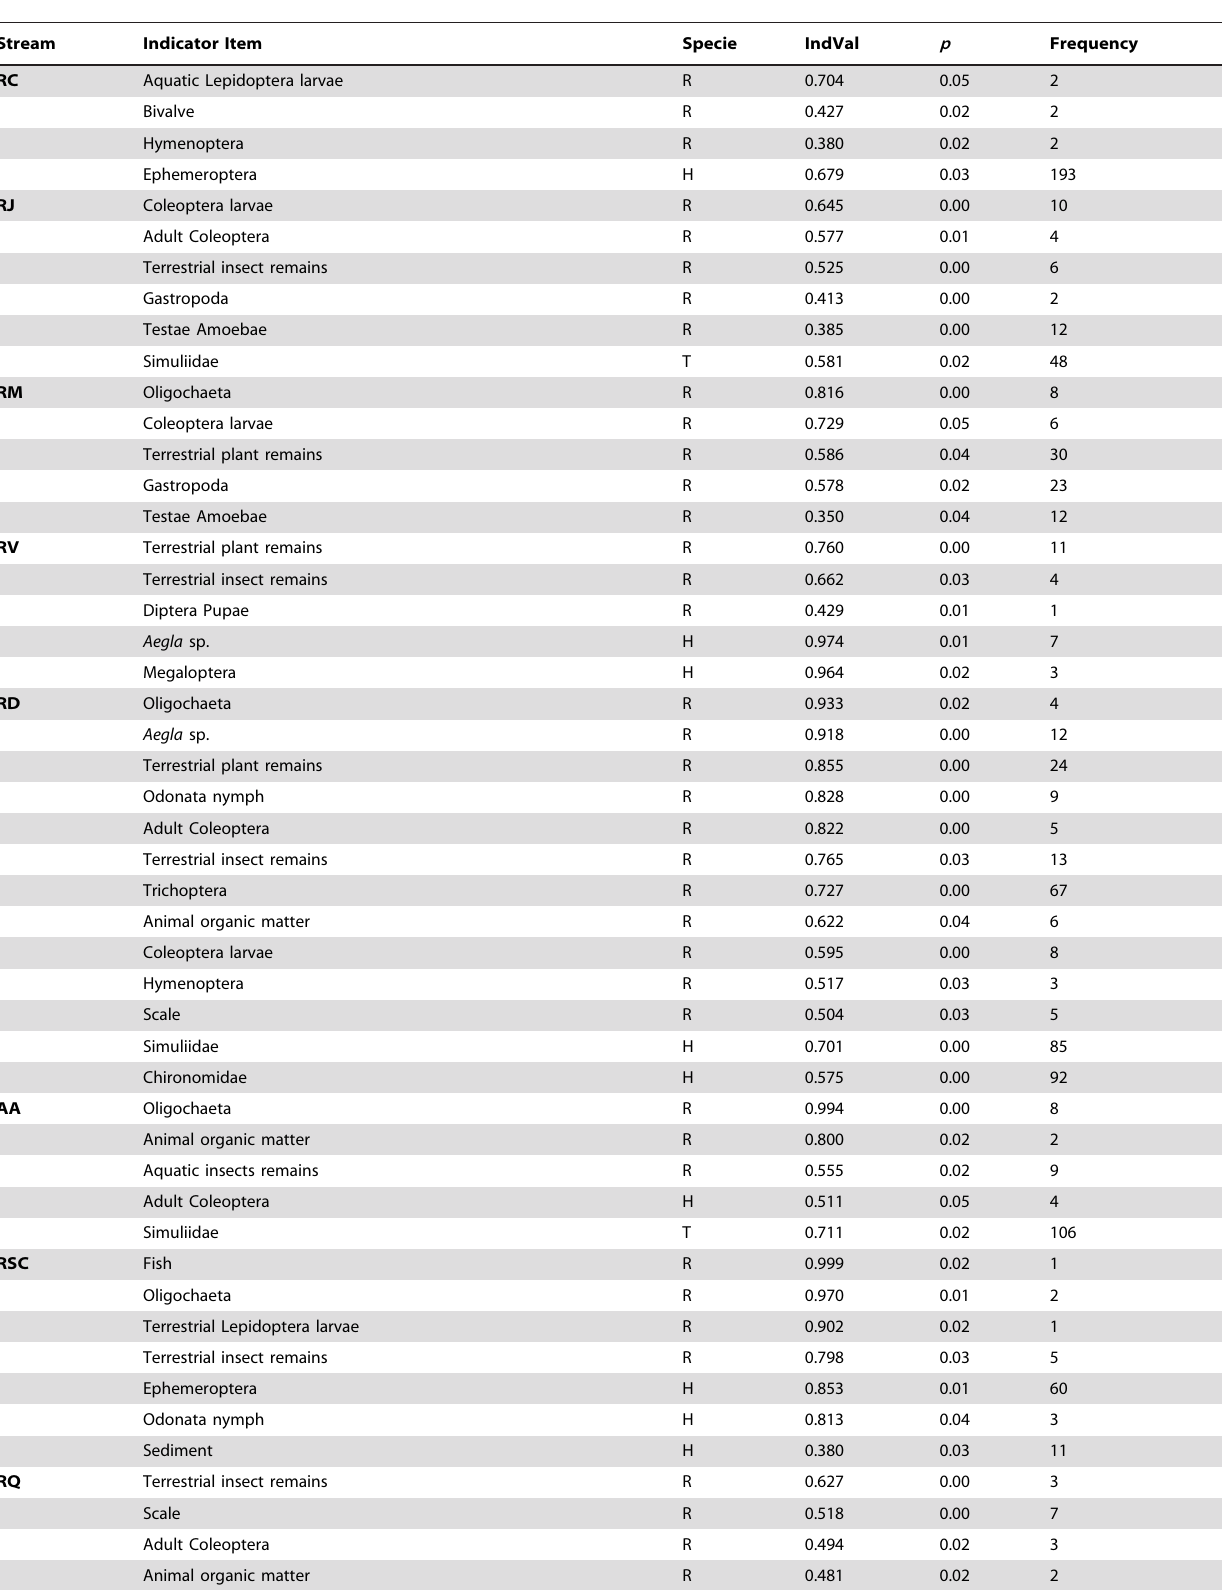
Table 3. Indicator Value (IndVal), p value and Frequency of food items consumed by three species analyzed, discriminated among species.